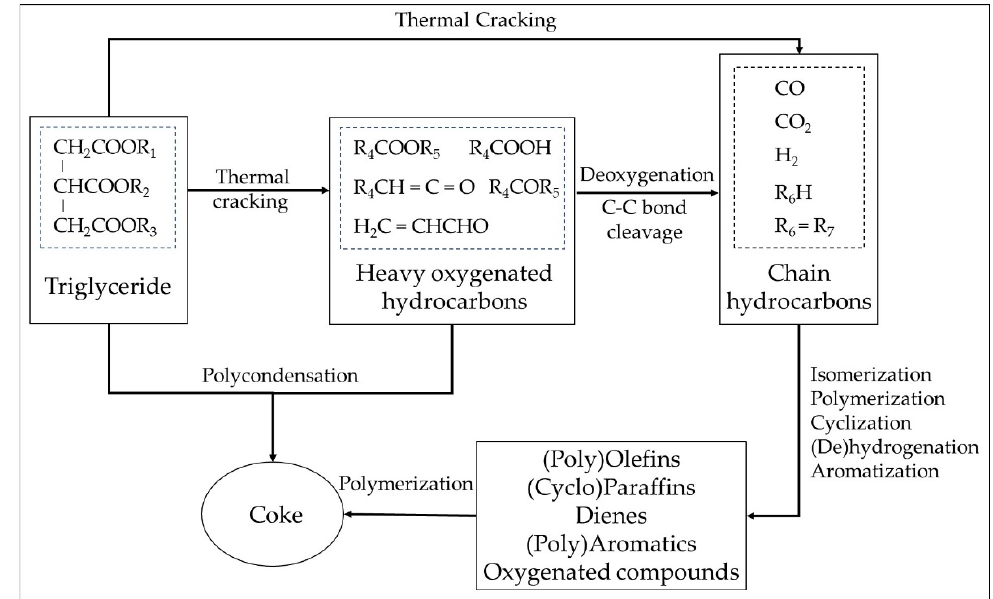
Figure 1. The reaction scheme for the pyrolysis of triglycerides over an activated carbon adapted from [20,26].